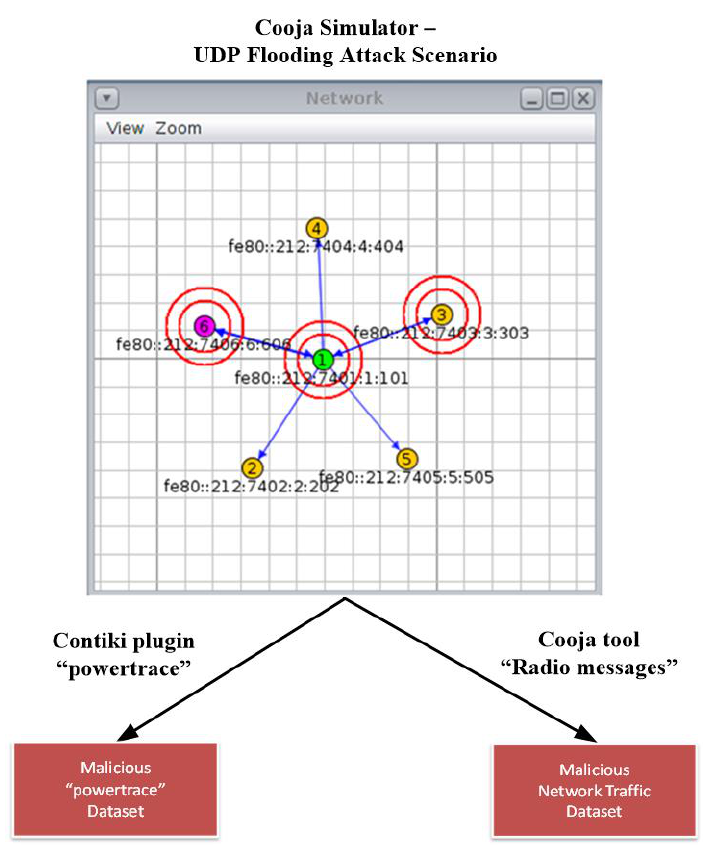
Figure 24. Malicious datasets generation by utilizing the Cooja simulator. Sensors 2020 , 20 , x FOR PEER REVIEW